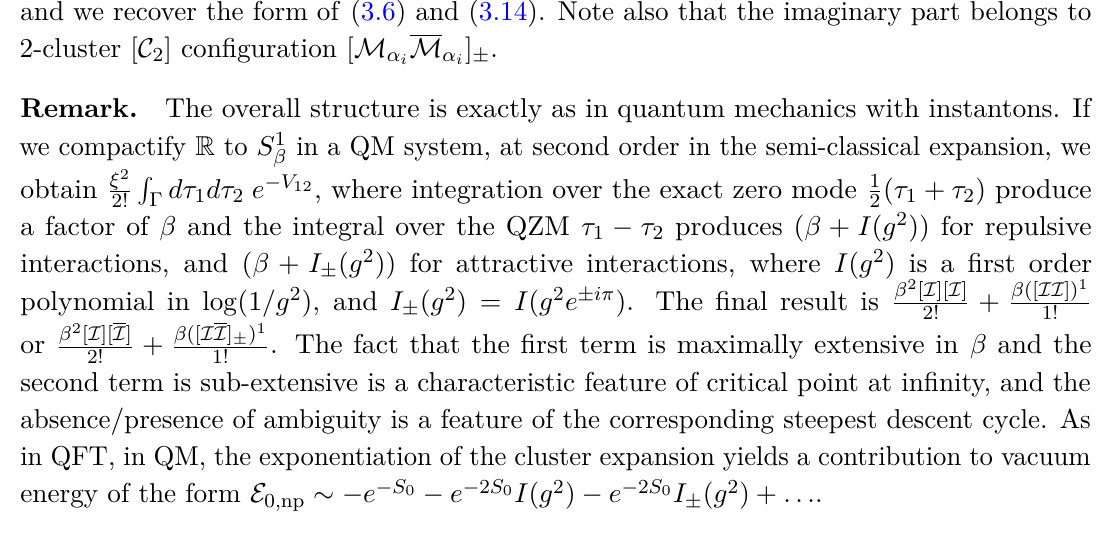
Figure 3 . Γ( − 3 , δ ) has a branch cut along the negative real axis. It is possible to compute it at a point − δ 0 on the cut by analytically continue its value from δ 0 < lead complex conjugate results so that the function Γ( − 3 , δ ) . This is the source of the ambiguous result of